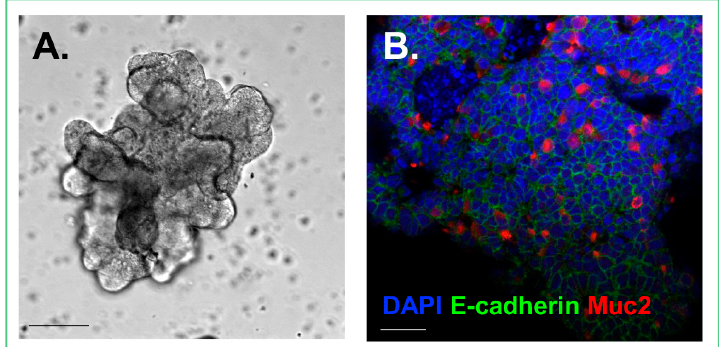
Figure 1. Cultured enteroid. ( A ) Photomicrograph demonstrating the architecture of an enteroid; ( B ) Confocal image of an enteroid stained for DAPI (Blue), E-cadherin, an epithelial cell marker (Green), and Muc2, a goblet cell marker (Red). Size bars = 50 μ m.